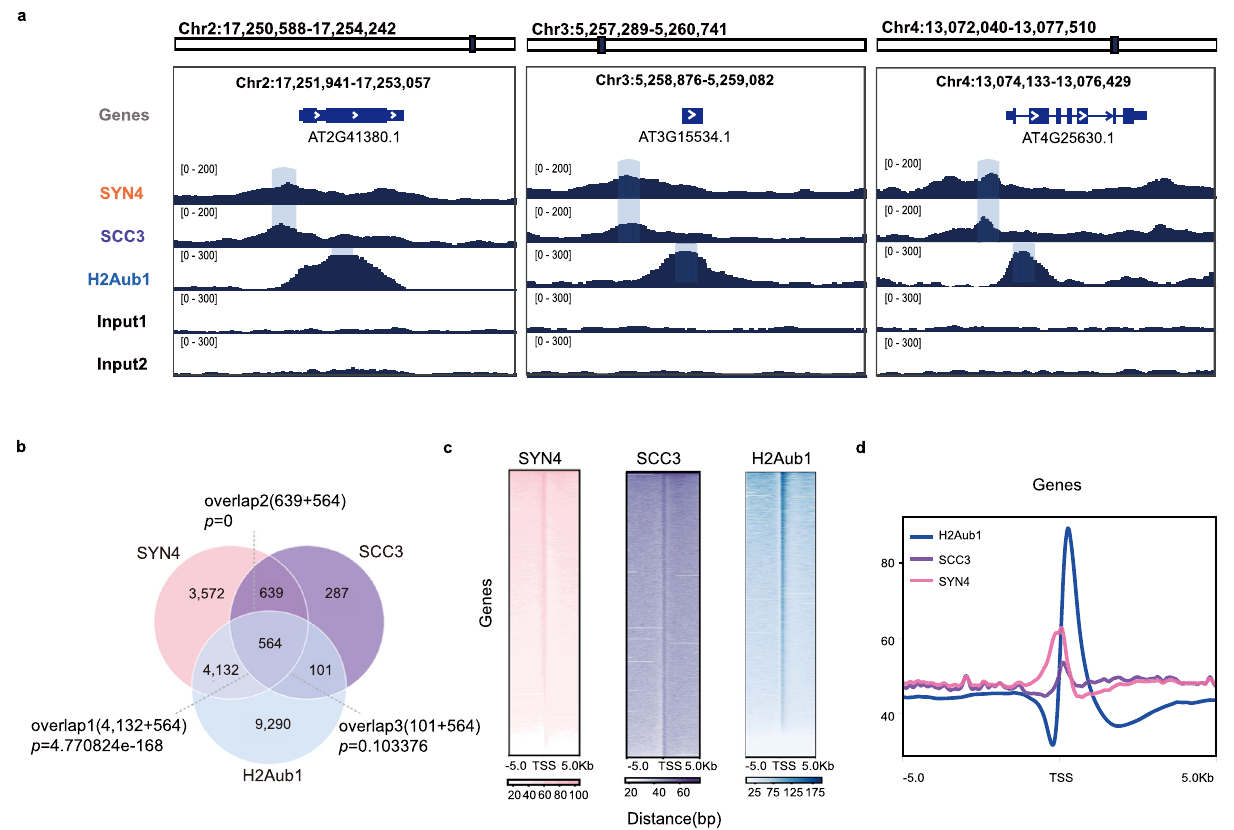
Fig.3|Co-occupiedAtSYN4andAtSCC3locateadjacenttoH2Aub1sitesacross the TSS in the genome. a IGV screenshots of AtSYN4, AtSCC3, and H2Aub1 showing enrichments at the loci of selected genes. Three genes selected are AT2G41380 (Chr2:17,251,941 – 17,253,057), AT3G15534 (Chr3:5,258,876 – 5,259,082),and AT4G25630 (Chr4:13,074,133 – 13,076,429). b Venn